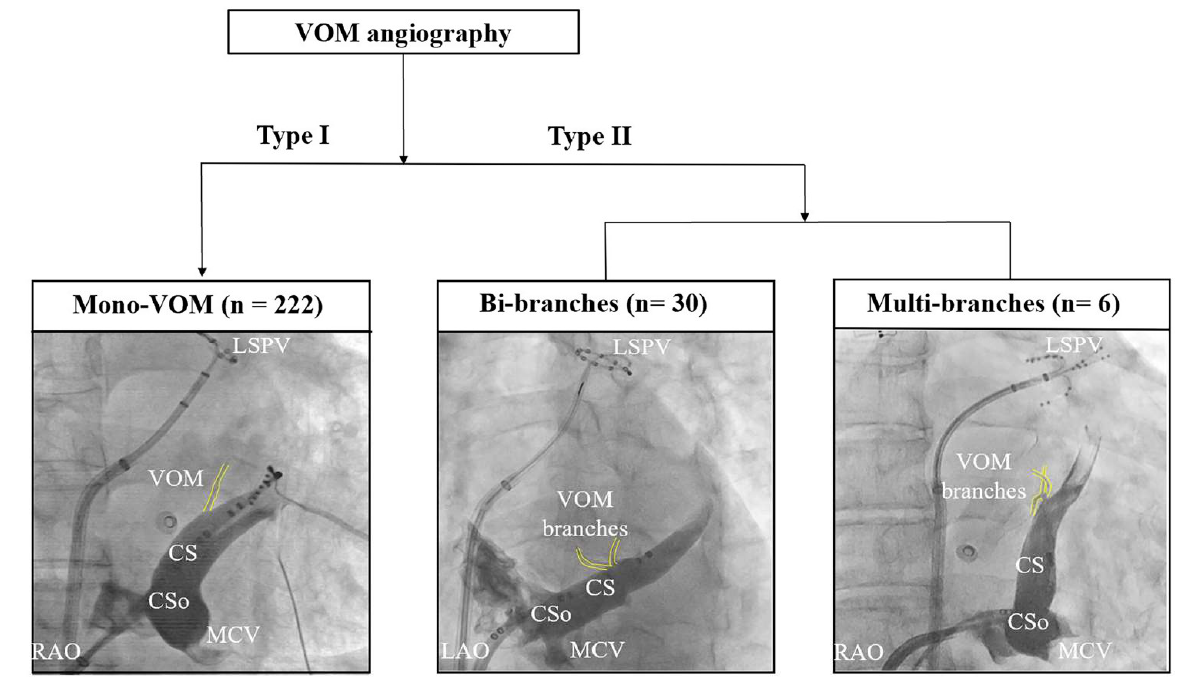
Figure 3. Morphologic classification of the VOM. CS = coronary sinus; CSo = coronary sinus ostium; LAO = left anterior oblique; LSPV = left superior pulmonary vein; MCV = middle cardiac vein; RAO = right anterior oblique; VOM = vein of Marshall.